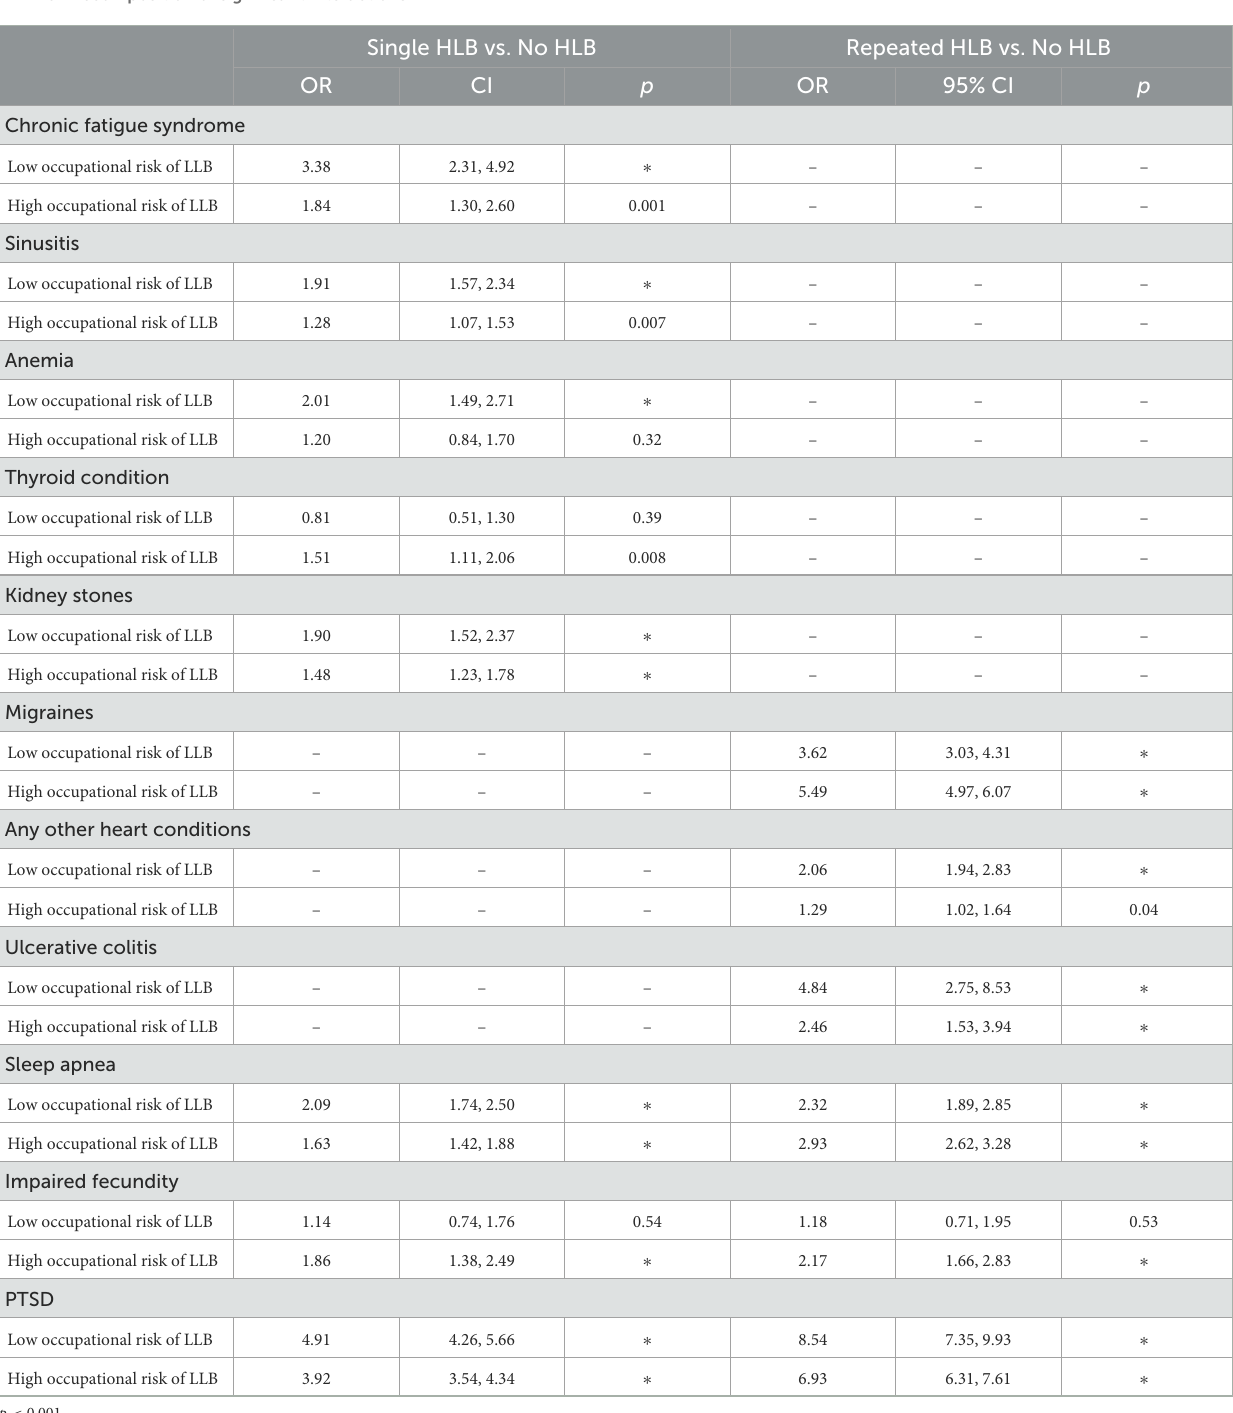
TABLE 3 Decomposition of significant